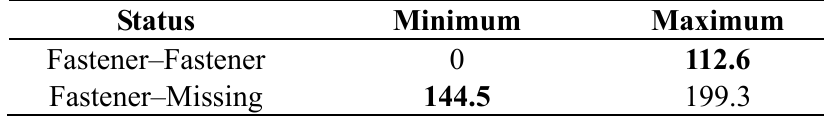
Table 1. Intra and interclass distances using the angle absolute difference value.